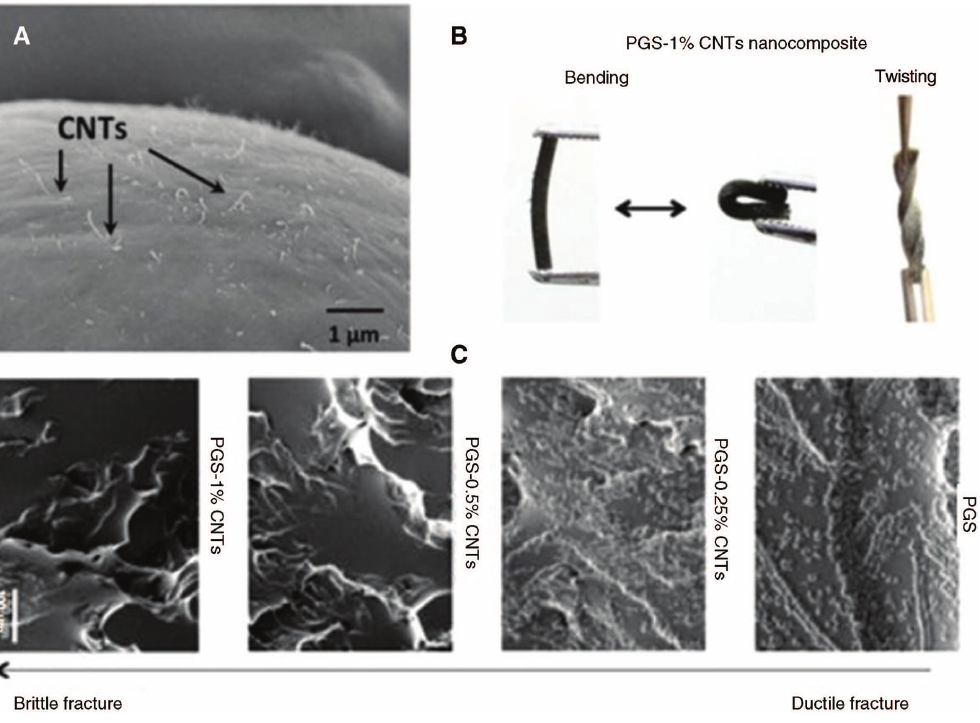
Figure 3: (A) The SEM image of the freeze-fractured surface of PGS-1% CNT nanocomposites showing uniform distribution of CNTs on the surface. (B) PGS-CNT nanocomposites showing high flexibility and can sustain bending and twisting. (C) The SEM images of the fractured surfaces of PGS-CNT nanocomposites after tensile testing. Reproduced from Ref. [8] with permission of The Royal Society of